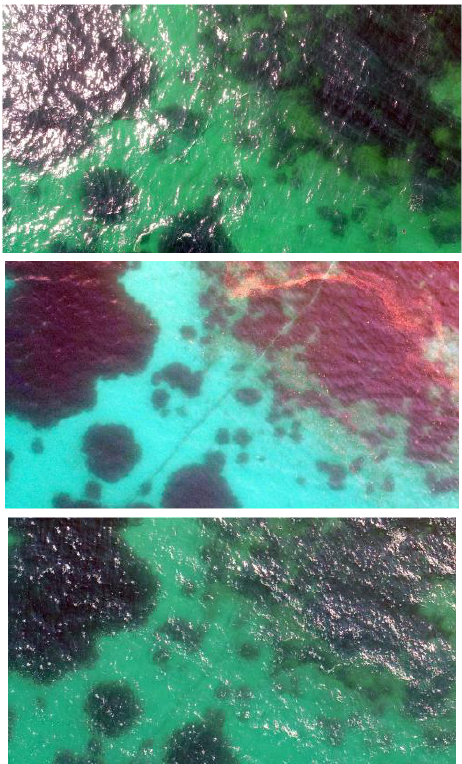
Figure 4 Subsets of the orthophoto-map on 16/04/19 (top), 17/04/19 (middle), 18/04/19